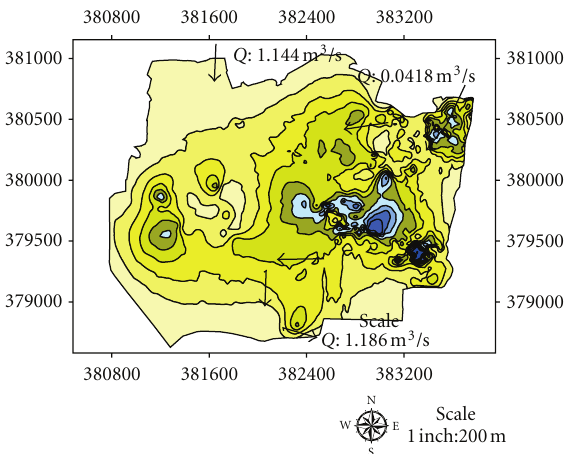
Figure 11: Average flow from western part of the catchment.